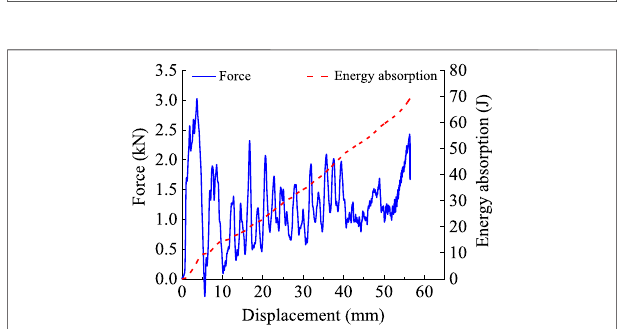
FIGURE 7 | Force and energy absorption-displacement curves for specimen CCF1 at 71.4 s − 1 .